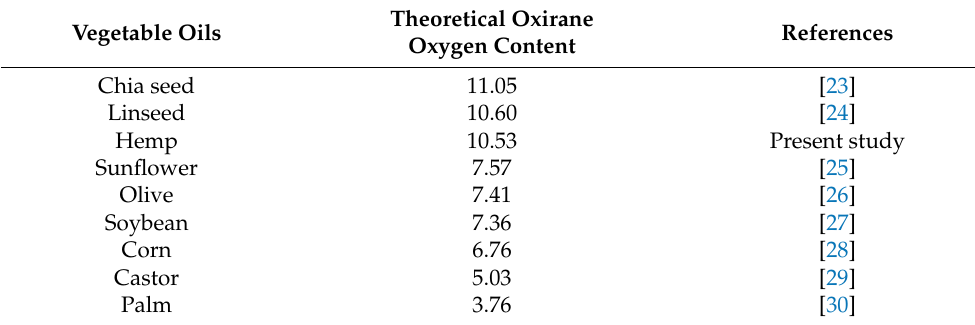
Table 1. Oxirane oxygen content of different vegetable